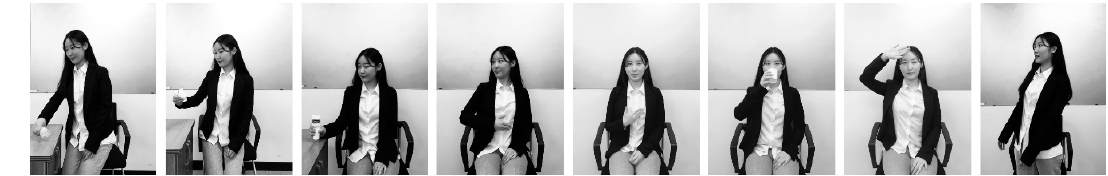
Figure 1. All eight agent images used in manipulation check for determining whether there were significant differences between mean scores for ratings of their attractiveness and naturalness across agent identity .